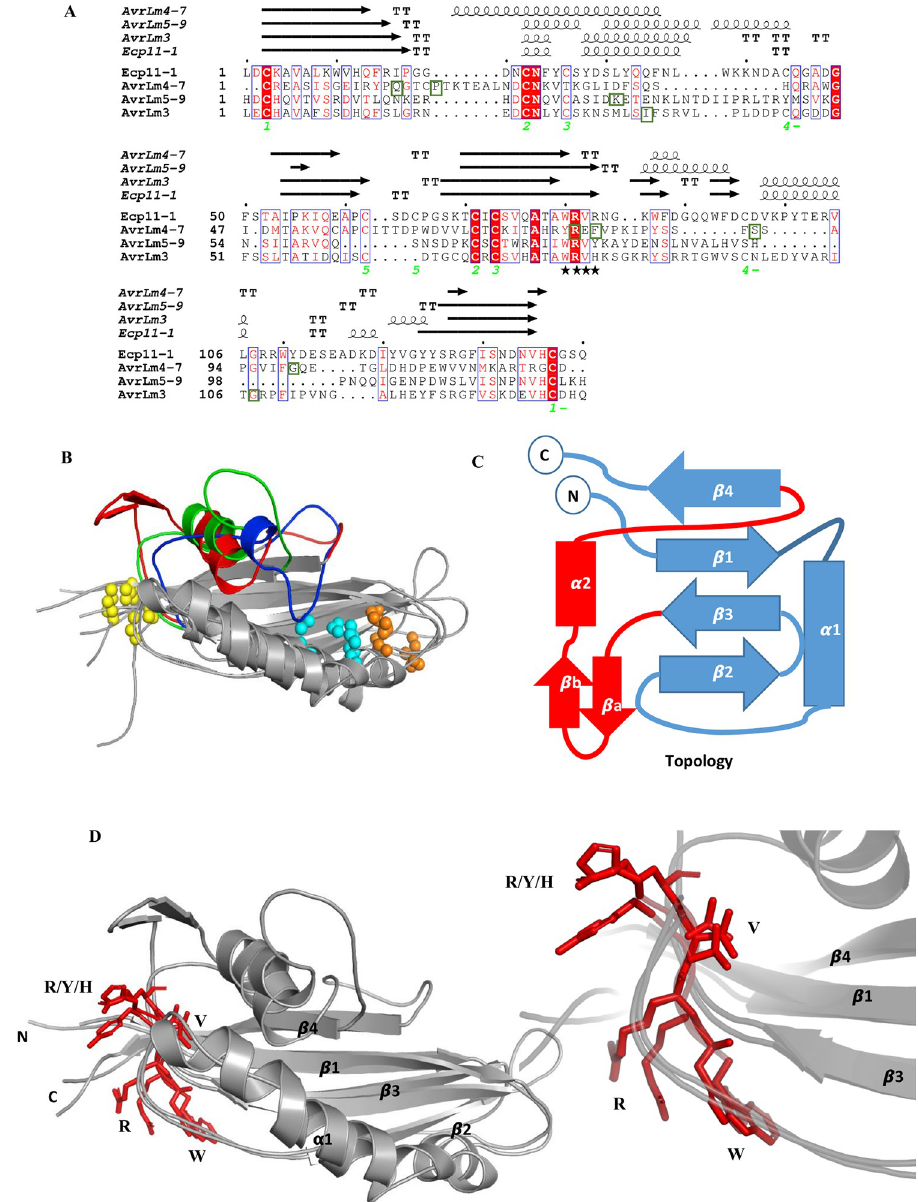
Fig 2. AvrLm4-7, AvrLm5-9, AvrLm3 and Ecp11-1 are structural analogues. (A) Structure-based protein sequence alignment of AvrLm4-7, AvrLm5-9, AvrLm3 and Ecp11-1. The S-S bridges of Ecp11-1 are labelled green and numbered to show their connectivity. Secondary structure for each protein ( β -sheets, α -helices, and β -turns are rendered as arrows, squiggles and TT letters respectively) is shown above the alignment. Identical residues are in red boxes and similar residues are in red. The conserved motif WR(F/L/V)(R/K) is labeled by black stars. The residues for whom mutations are associated with a switch to virulence are in green boxes. The figure was made with the ESPript server [66]. (B) Superposition of AvrLm4-7, AvrLm5-9 and AvrLm3. The variable connections between β 3 and β 4 are coloured in red (AvrLm3), blue (AvrLm4-7) and green (AvrLm5-9). The conserved or neighbouring S-S bridges are indicated as yellow, orange and cyan spheres (indicated as 1, 2 and 3, respectively, in panel A). (C) Representation of conserved topology, with the variable connexion between β 3 and β 4 coloured in red. (D) Superposition of AvrLm5-9, Ecp11-1 and AvrLm3 (all in grey), with their conserved WR(F/L/V)(R/K) motif at the exit of β 3 represented by red sticks. A zoom on the motif is represented in the lower right corner.